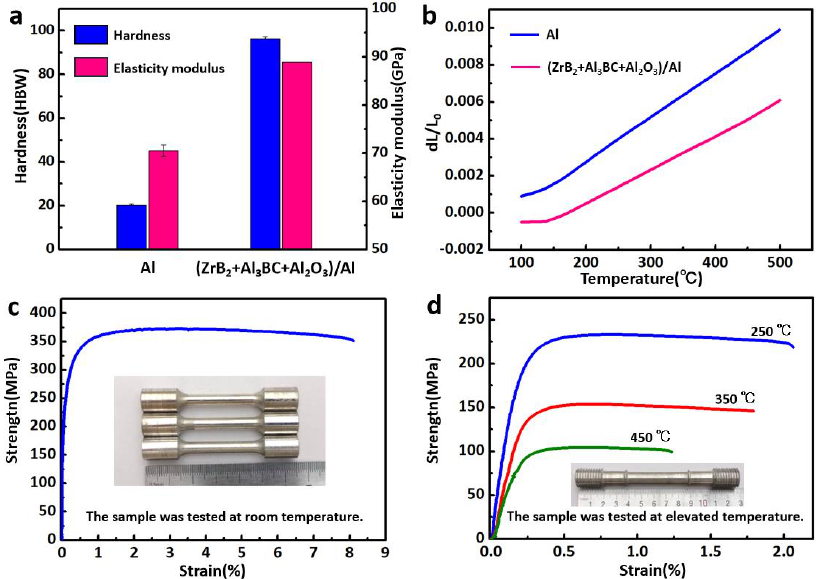
Figure 5. The hardness, elasticity modulus ( a ) and thermal expansion curves ( b ) of pure Al and the composite; ( c , d ) are the tensile curves of the composite tested at room temperature and elevated temperature. Table 1. The tensile properties of the composite at different temperatures.